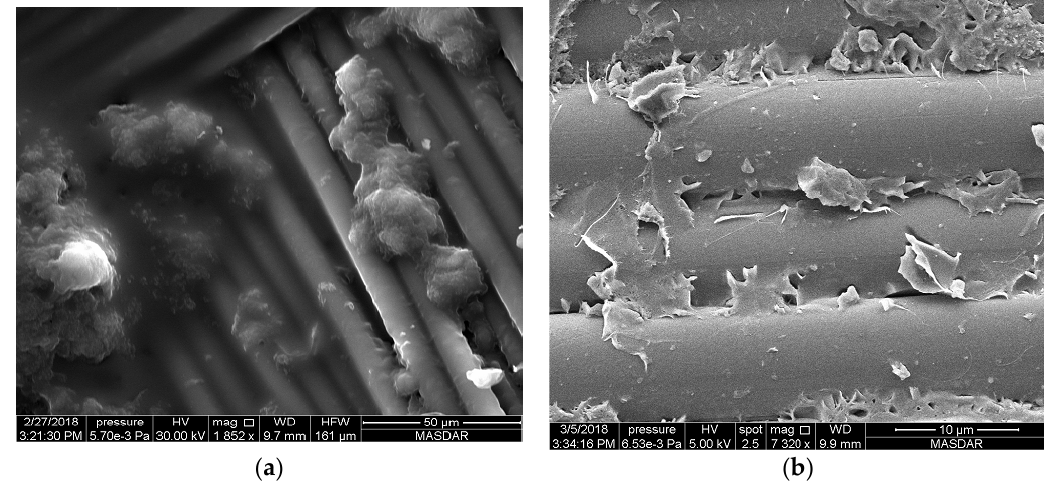
Figure 6. SEM image of Kevlar reinforced epoxy with 1.0% of carbon nanotubes at different magnifications. ( a ) 1852× ( b ) 7320×.